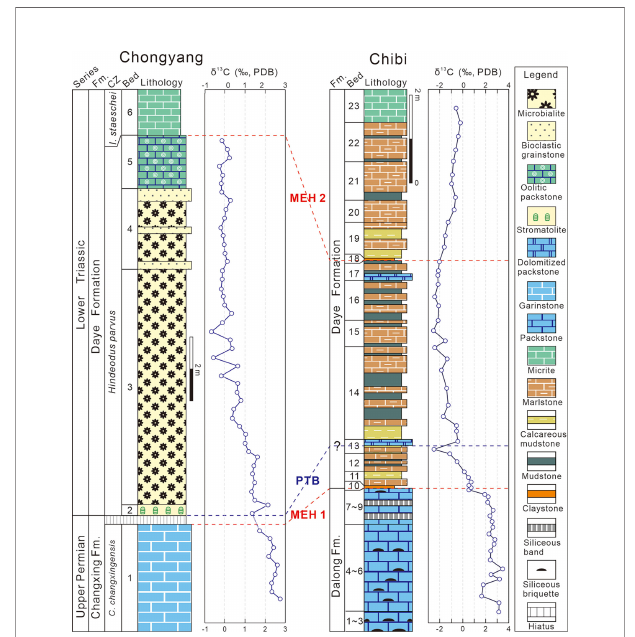
FIGURE 2 | Columnar sections of P – Tr successions of the Chongyang and Chibi sections. Conodont zonation of the Chongyang section from Yang et al. (2006) and Wang et al. (2019). The d 13 Ccarb of the Chongyang section from Wang et al. (2019). CZ, conodont zones; C. , Clarkina ; I., Isarcicella ; MEH, mass extinction horizon; PTB, P – Tr